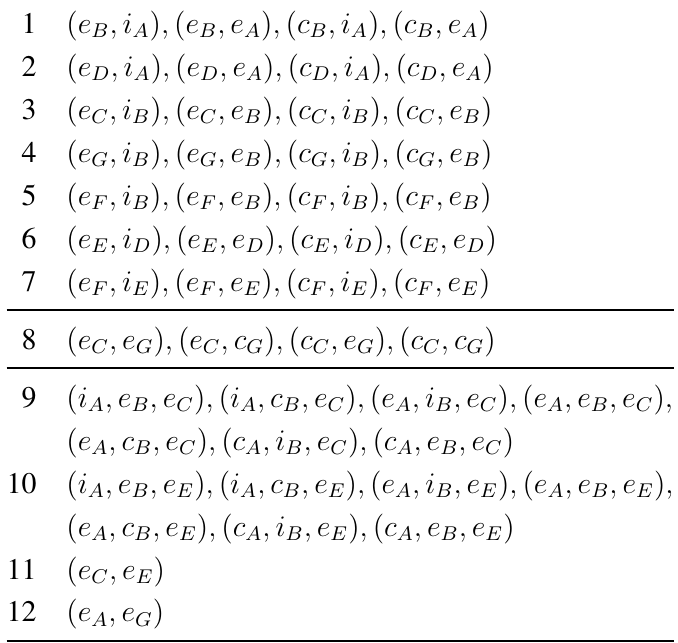
Table 1. Forbidden state combinations to model the dependencies for Example